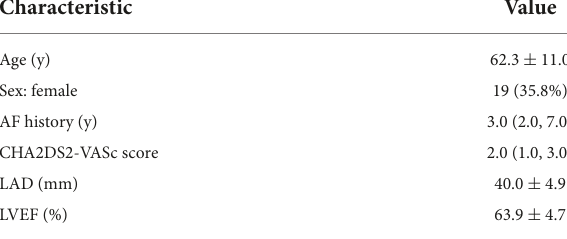
TABLE 1 Baseline clinical characteristics ( N =